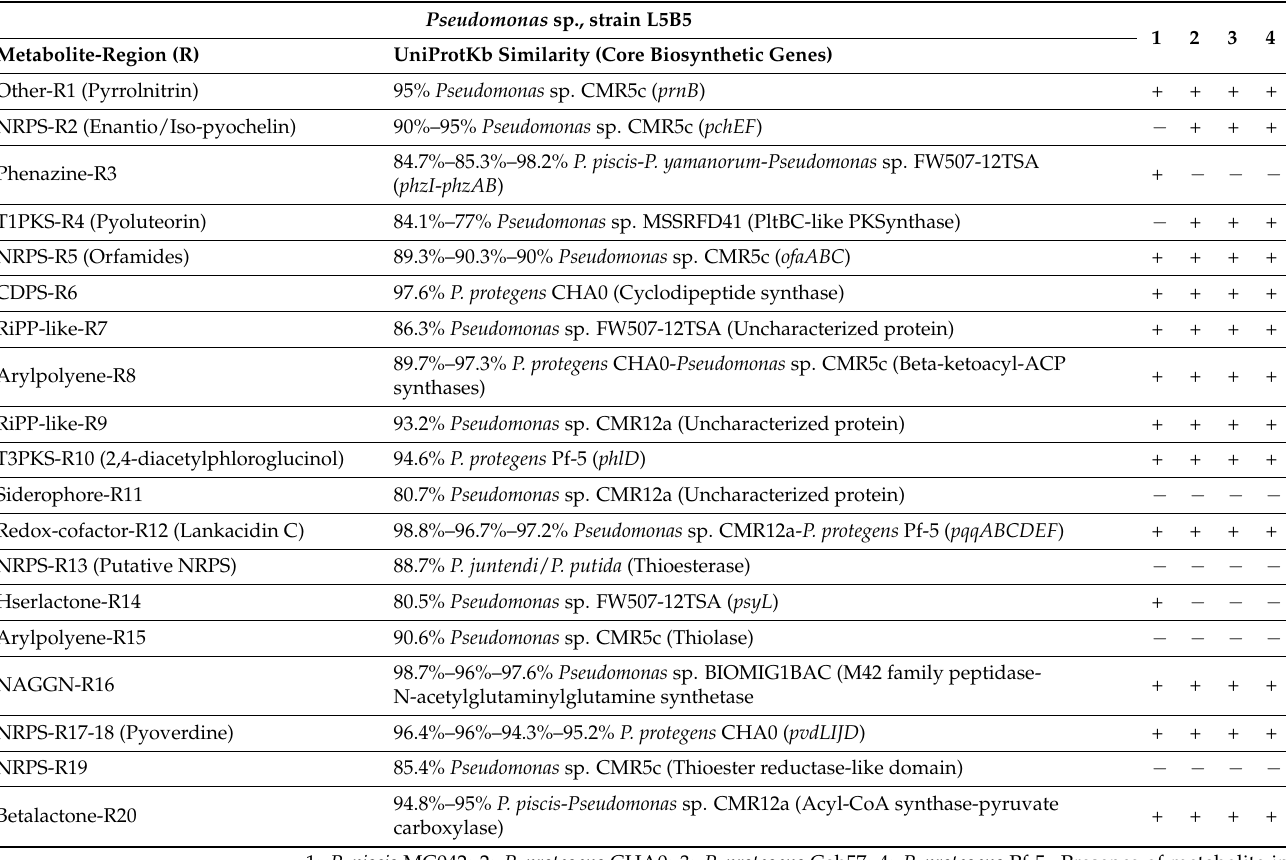
Table 1. Prediction of secondary metabolites in Pseudomonas sp., strain L5B5. Similarity of core biosynthetic genes and presence of metabolites in closer relatives are shown. Pseudomonas sp., strain